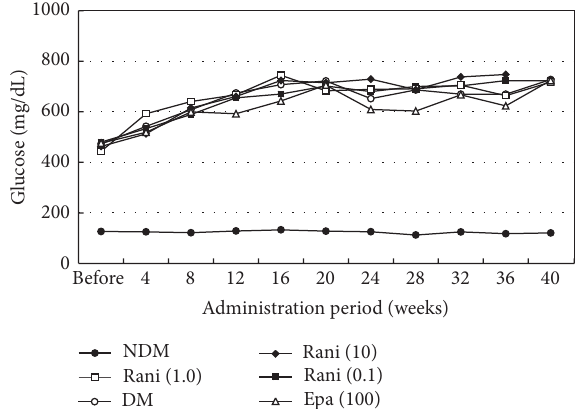
Figure 2: Blood glucose levels of the study animals. The mean blood glucose levels of the SD rats are significantly lower than those of the SDT rats with or without treatment. There is no significant difference in the blood levels among the SDT rats with or without treatment. NDM: normal SD rats; DM: untreated SDT rats;rani(0.1):ranirestat-treatedSDTrats(0.1mg/kg/day);rani(1.0): ranirestat-treated SDT rats (1.0mg/kg/day); rani (10): ranirestat- treated SDT rats (10mg/kg/day); epa (100): epalrestat-treated SDT rats (100mg/kg/day) [21].